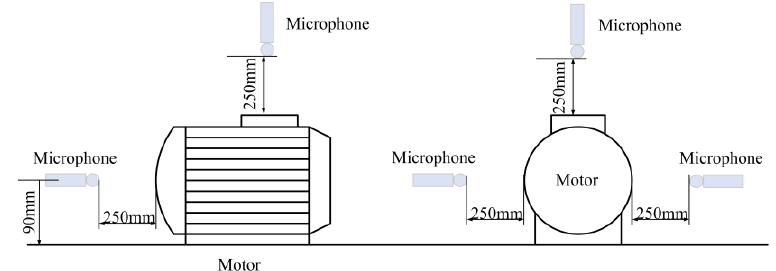
Figure 9. Diagram of the microphone arrangement .